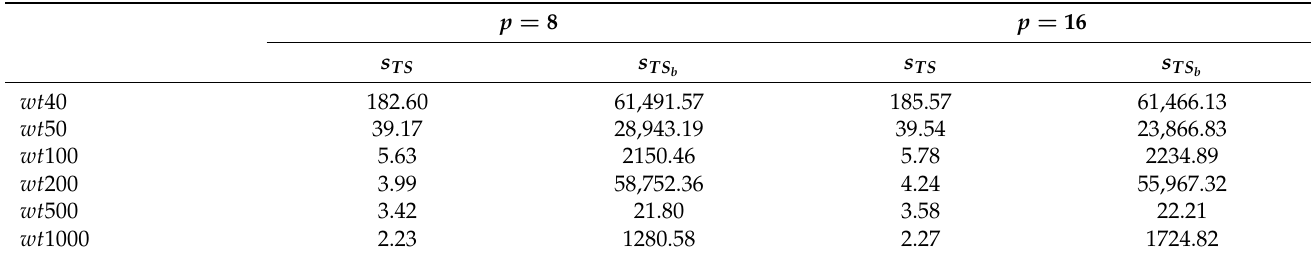
Table 4. Speedup values for parallel tabu search algorithm.